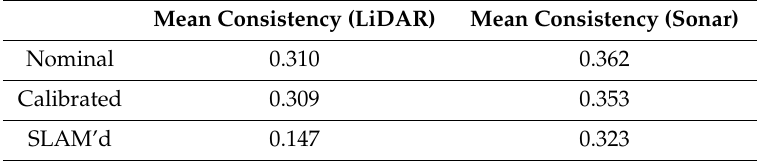
Figure 11. ( a ) Nominal sonar. ( b ) Nominal LiDAR. ( c ) Calibrated sonar. ( d ) Calibrated LiDAR. ( e ) SLAM’d sonar. ( f ) SLAM’d LiDAR. Table 3. Statistics for the Roman and Singh consistency-based error metric for the 3 LiDAR datasets. Mean Consistency